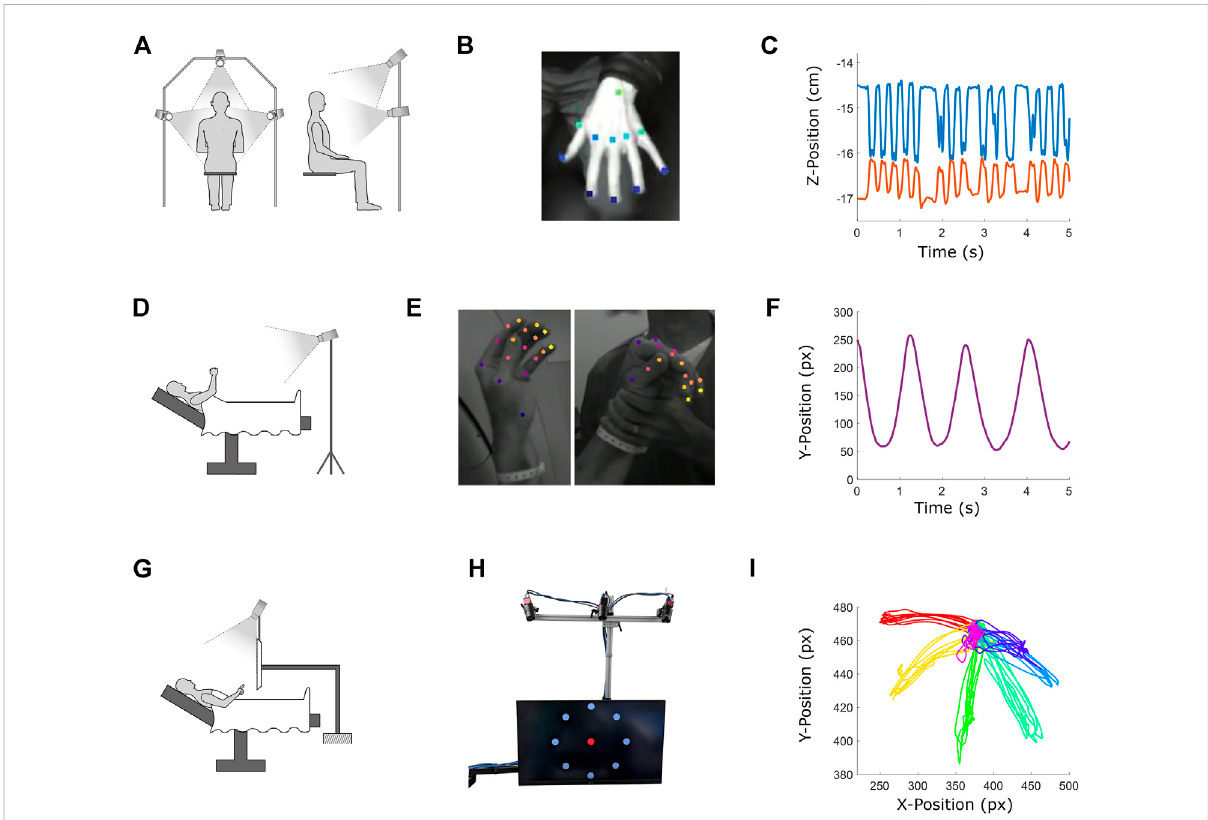
FIGURE 1 Description of three ongoing studies utilizing DeepLabCut (DLC) in clinical settings. Top row: Clinical trial using DLC for movement disorder assessment and diagnosis. Middle row: Development of an intraoperative tool for automated motor mapping during DBS implantation of STN for treatment of PD. Bottom row: Motor neuroscience experiment linking VIM unit activity to reach kinematics in ET patients. (A , D and G) depict the physicalsetupsforeachstudy. (B) Handtrackingduringaclinicalmovementdisorderexam. (C) OutputofDLCtrackingintheverticaldimension of pointer fi nger (blue) and thumb (orange) tips during a fi nger tap test. (E) Hand tracking during active (left) and passive (right) movements for intraoperativeMERbasedmotormapping.DLCisabletoidentifyandlabelthepatient ’ shandandnottheclinician ’ sduringpassivetesting. (F) Average camera coordinate vertical position in pixels of all fi ngertips during a “ chain pull ” movement as tracked by DLC. (H) Monitor and cameras used to administerandtrackthecenter-outreachingtask.Whilealltargetsaredisplayedsimultaneouslyhere,onlyonetargetwaspresentedatatimeduring the task. (I) DLC-tracked position in pixels of pointer fi nger tip over an entire center-out session, with each color representing reaches to and from a different target (seven targets total for this